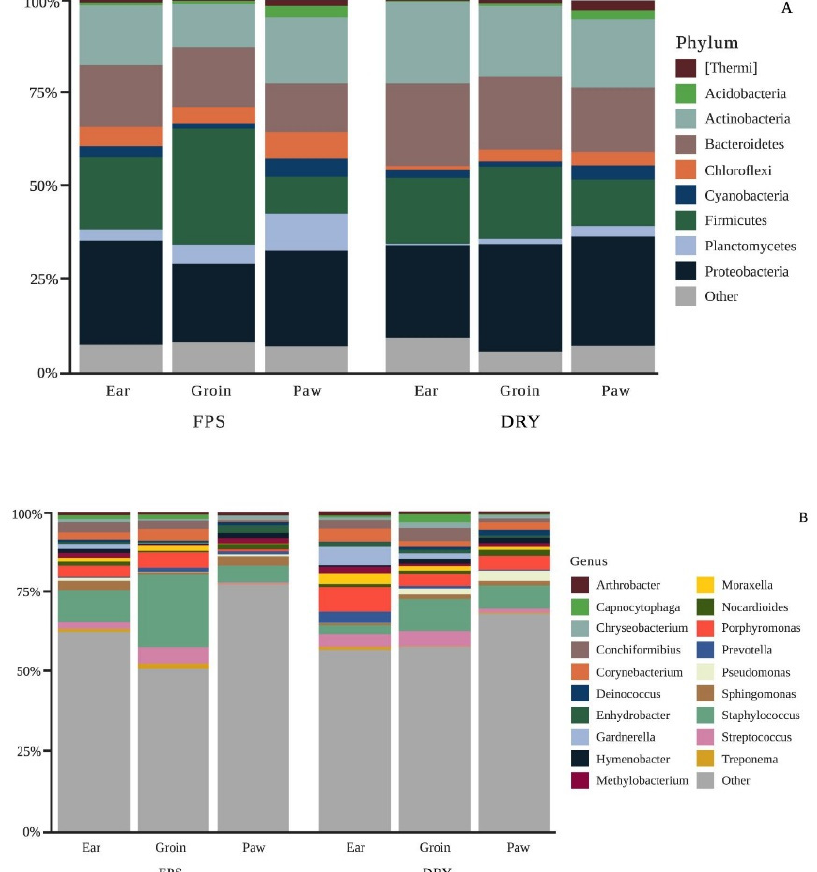
Figure 1. Taxonomic composition changes between body sites and diets. ( A ) Change of taxonomic composition of the skin microbial phyla and ( B ) genera for each body site between fresh (FPS) and dry (DRY) dog foods. Figures created with BioRender.com (Accessed on 15 February 2022). Supplementary Table S1 shows the relative percentages for each reported parameter. DRY compared to FPS ( p ≤ 0.05; Figure 2).